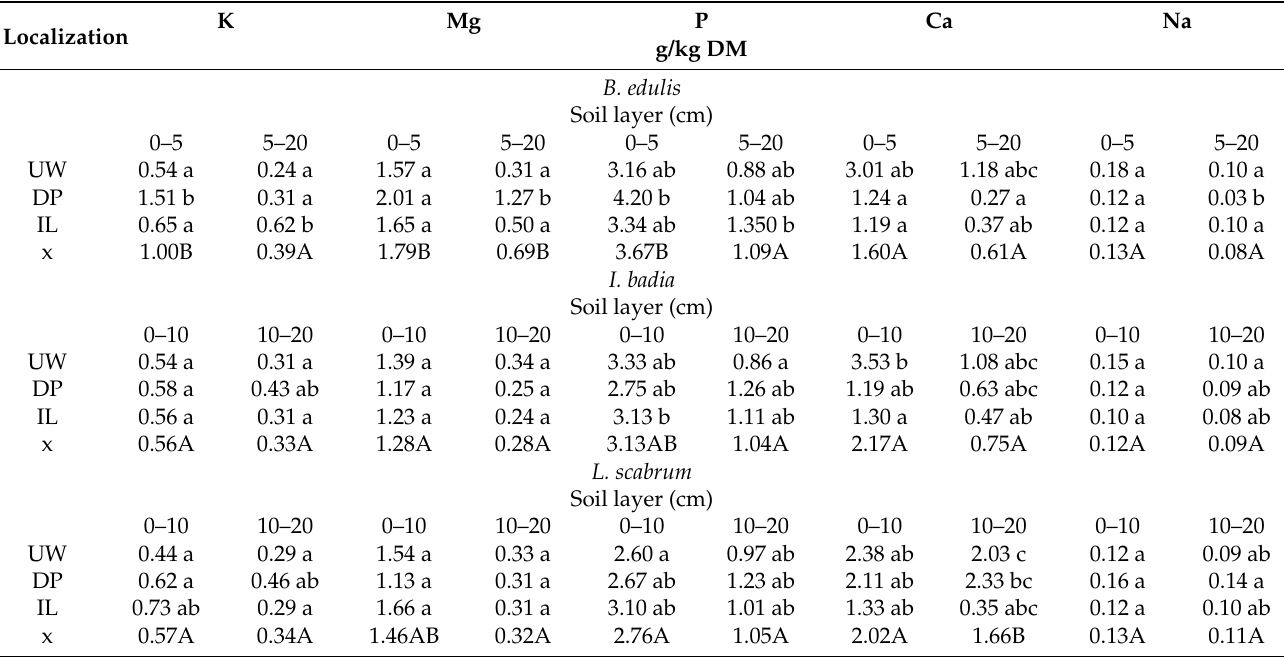
Table 2. Total content of macronutrients in